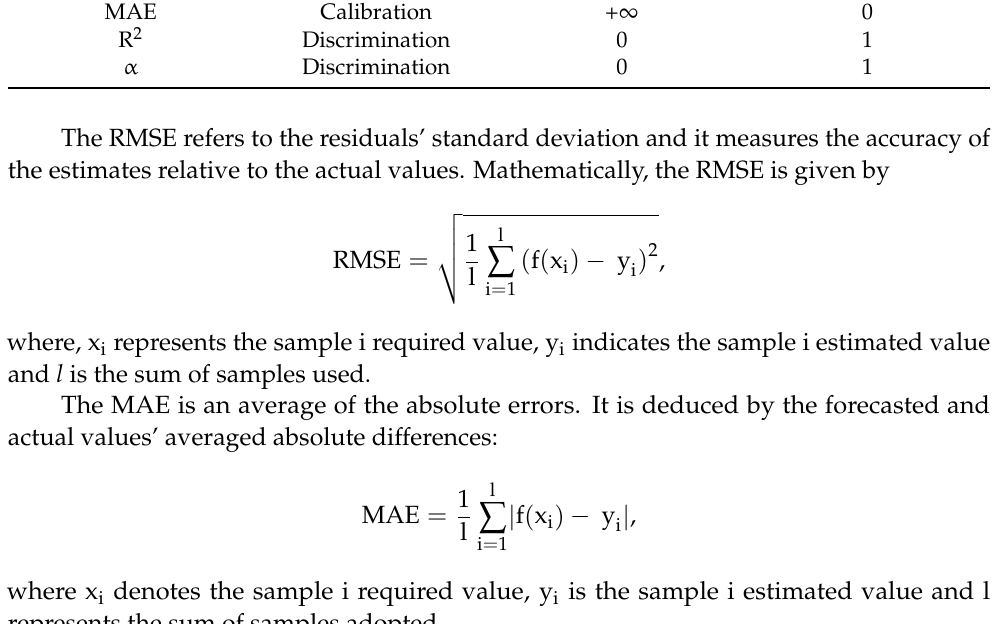
Table 2. Summary of the performance metrics for recovery rate models. Metric Measure Worst Best RMSE Calibration + ∞ 0 MAE Calibration + ∞ 0 R 2 Discrimination 0 1 α Discrimination 0